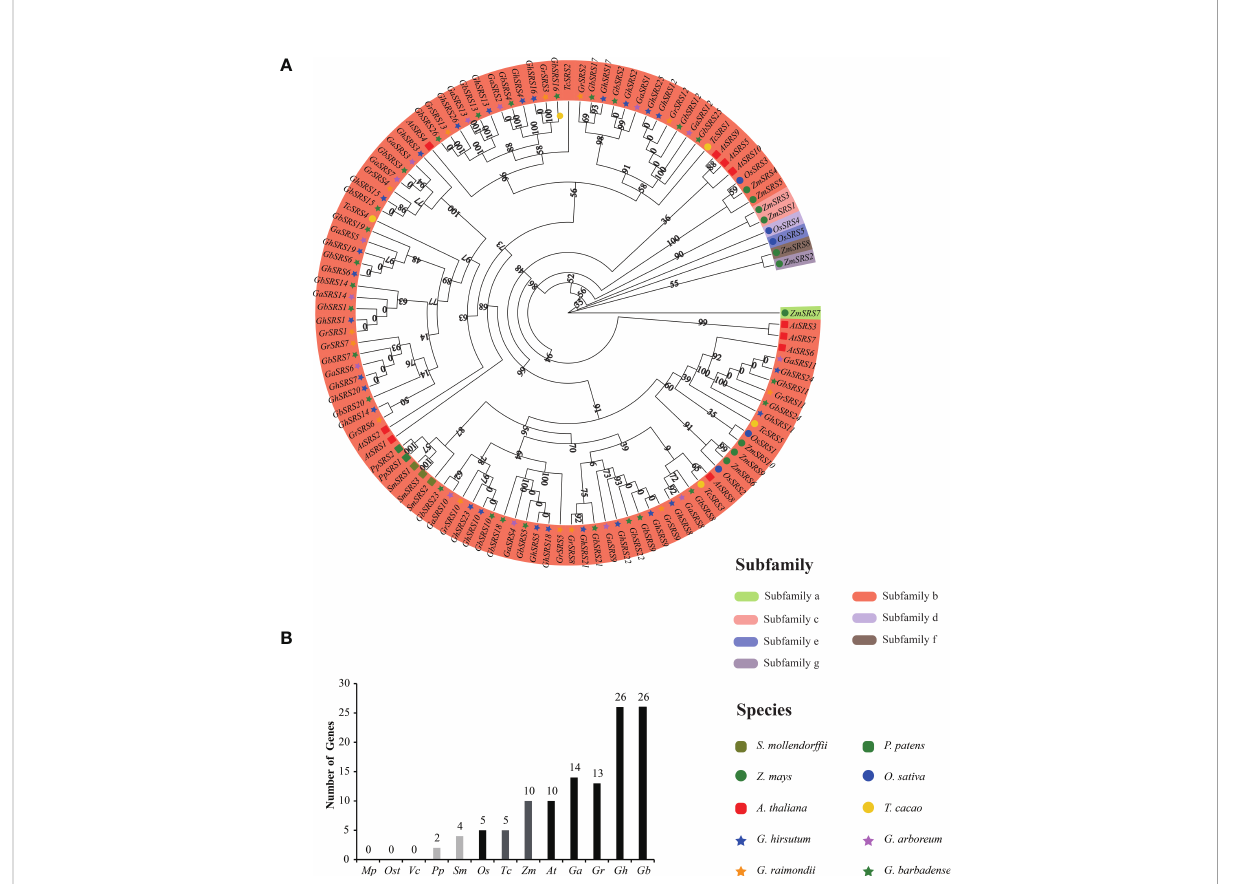
FIGURE 2 Phylogenetic and evolution relationships of the SRS gene family among different organisms (A) the rooted phylogenetic tree of the SRS gene family at the amino acid sequences level using the Maximum Likelihood method in Tbtools with 5000 bootstrap. The subgroup was divided according to the value on the node at the root of the evolutionary tree (the value>=80: all genes under this node belong to one subgroup; the value<80: all genes under this node can be further divided into two or more subgroups). (B) Comparisons of SRS gene numbers across a wide range of organisms. The pre fi x Mp , Ost , Vc , Pp , Sm , Os , Tc , Zm , At , Ga , Gr , Gh were used to describe the names of M. pusilla , Os. tauri , V. carteri , P. patens , S. moellemdorf fi i , O. sativa , T. cacao , Z. mays , A thaliana , G arboreum , G raimondii , G barbadense , G hirsutum ,